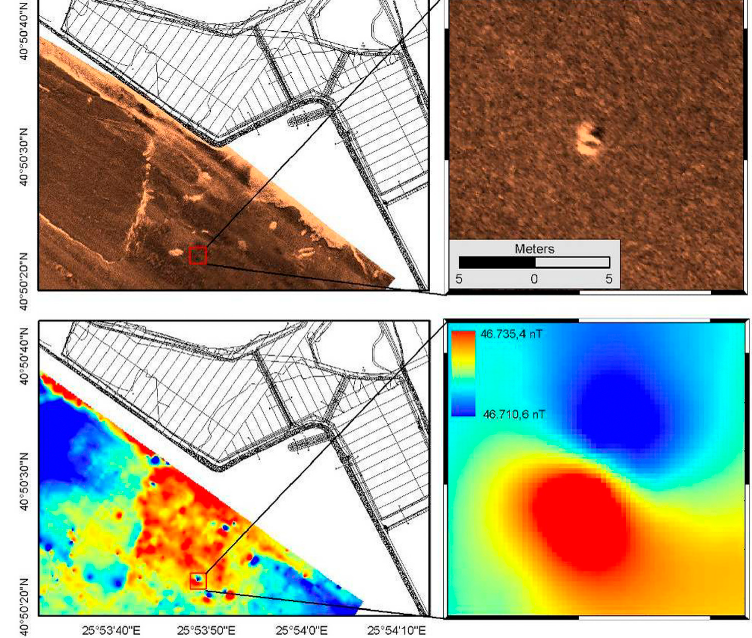
Figure 4. Example of manual target detection of manmade proud targets through SSS and marine magnetic data interpretation.